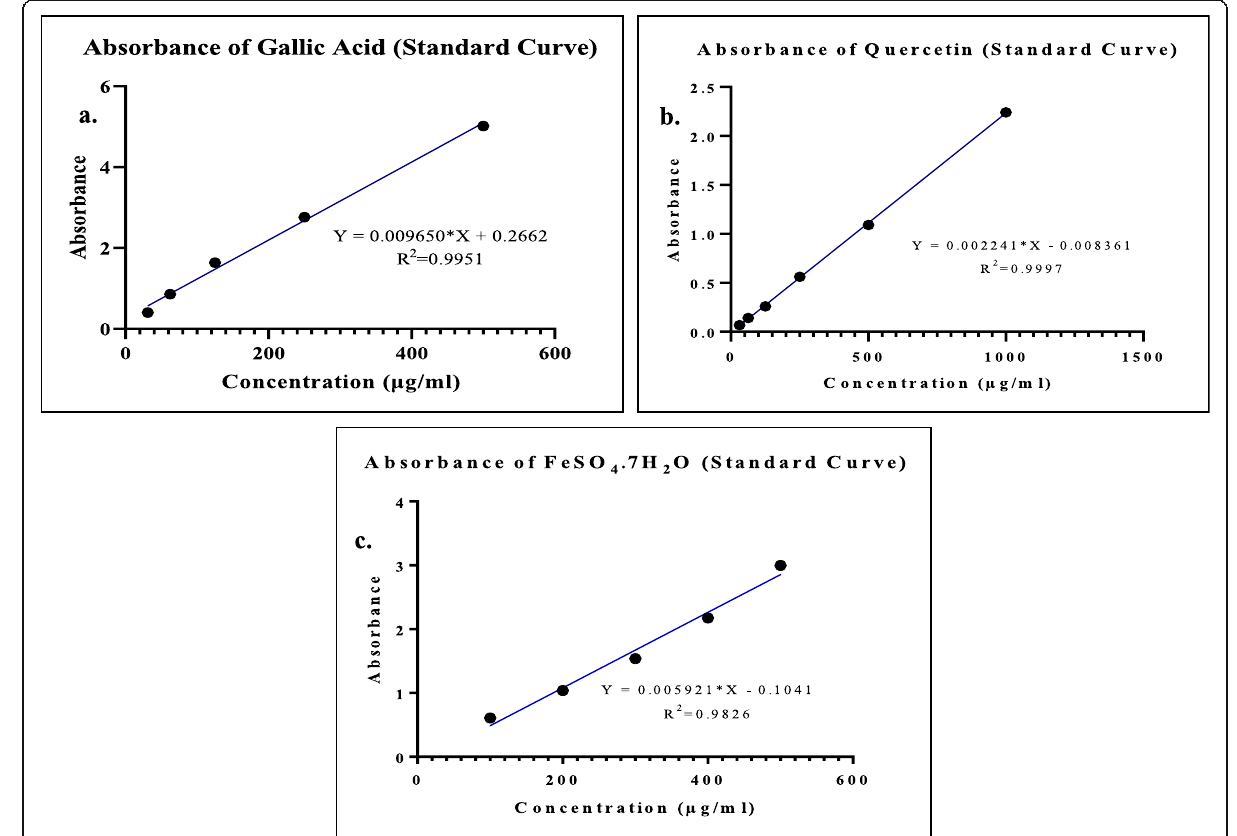
Fig. 1 Standard curve of (a). Gallic acid, (b). Quercetin and (c). FeSO 4 .7H 2 O